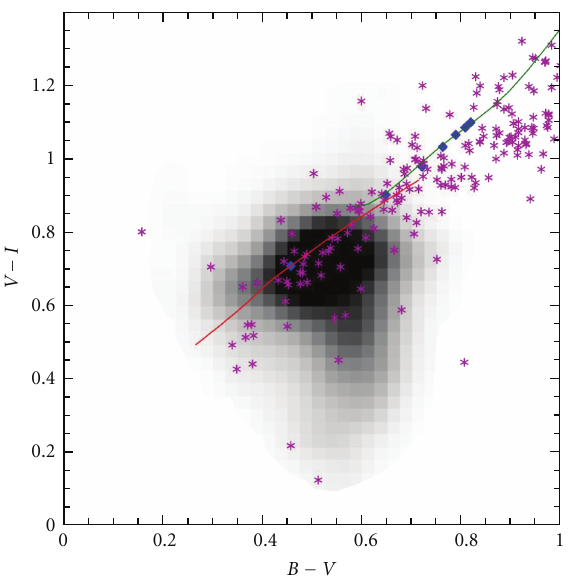
Figure 17: BVI color plane for pixels in LSB galaxies. Pixels were selected to be above 25Vmag arcsec − 2 , solid symbols are again RC3 galaxies plus 13 and 1 Gyrs stellar population